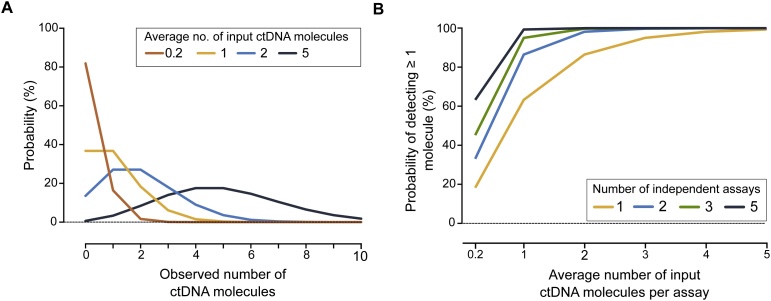
Probability of ctDNA detection due to sampling effects. (A) The probability of detecting a specific number of ctDNA molecules is shown when the average number of input ctDNA molecules is changed, e.g., if analyzed plasma volume is altered. (B) The probability to detect ≥ 1 ctDNA molecule when the average number of ctDNA molecules per sample changes from 0.2 to 5, as well as when the number of assays increases from one to five is shown.